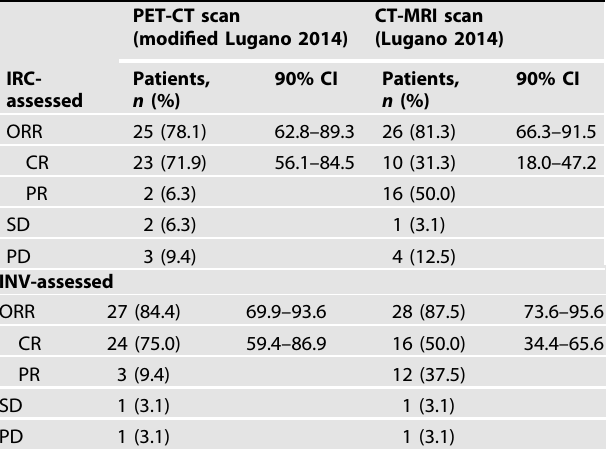
Table 2. IRC- and INV-assessed response rates at EOI (lenalidomide 20 mg cohort, n = 32 evaluable patients; primary analysis).